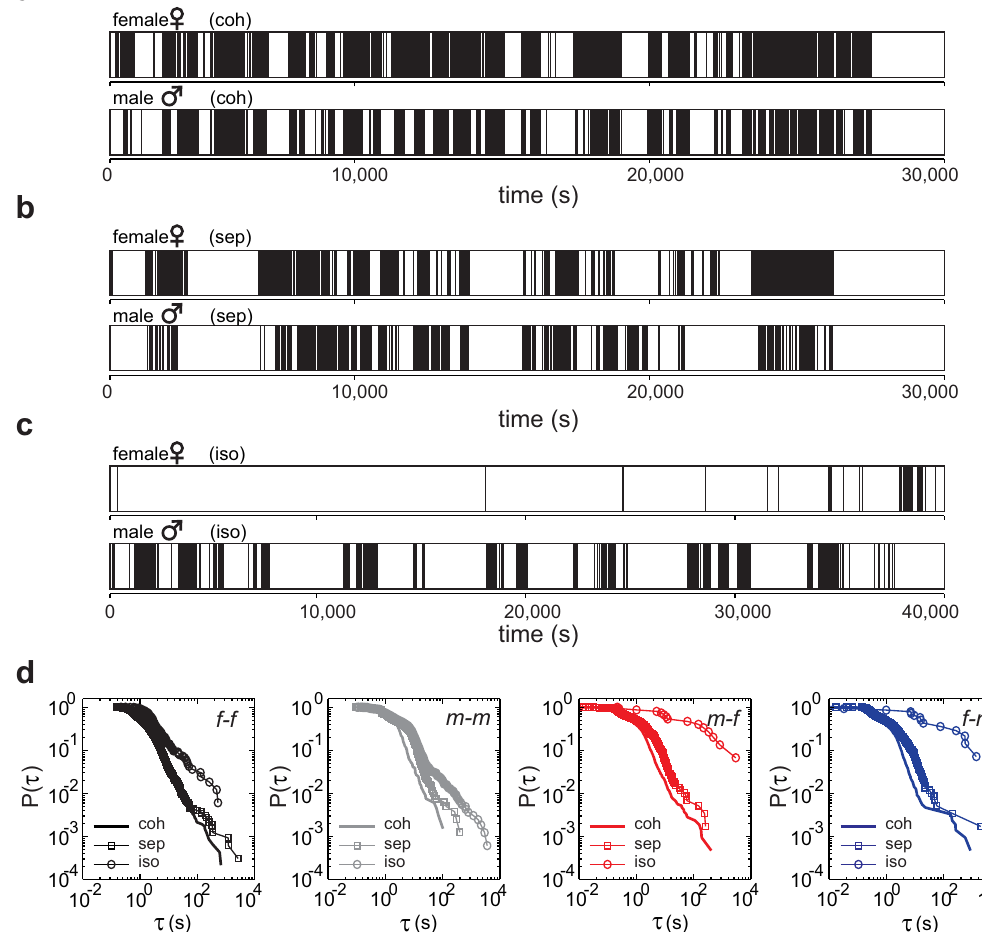
Figure 3. The power-law scaling of the self-contained (“ f-f ”, “ m-m ”) and of the reactive (“ m-f ”, “ f-m ”) callings change independently. Data are shown from the female-male pair “u”. ( a ) Successions of calling events of a female and a male during cohabitation (coh). ( b ) Successions of calling events of a female and a male after separation (sep) of the birds into two acoustically interconnected chambers allowing only acoustic interactions. ( c ) Successions of calling events of a female and a male after separating the birds into two chambers without any interconnection, neither visual nor auditory (iso = isolation). ( d ) Comparison of empirical cumulative distribution functions (eCDFs) between the inter-event intervals ( τ ) of cohabitation (coh), separation (sep), (sep) and isolation (iso). Note that the exponents changed dramatically only after isolation of the male and female zebra finches. P( τ ): the cumulative distribution of the inter-event intervals; τ (s): the inter-event intervals in